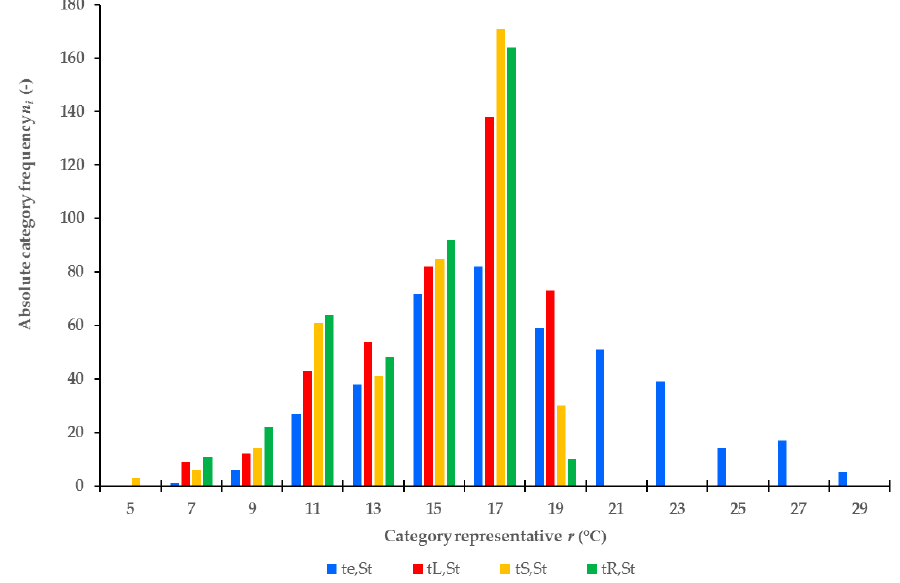
Figure 5. Frequencies of average daily temperatures of the ground mass ( t L , St , t S , St ), reference ground mass ( t R , St ), and ambient temperatures ( t e , St ) during periods of stagnation of the HGHE occurring between 2012 and 2015.